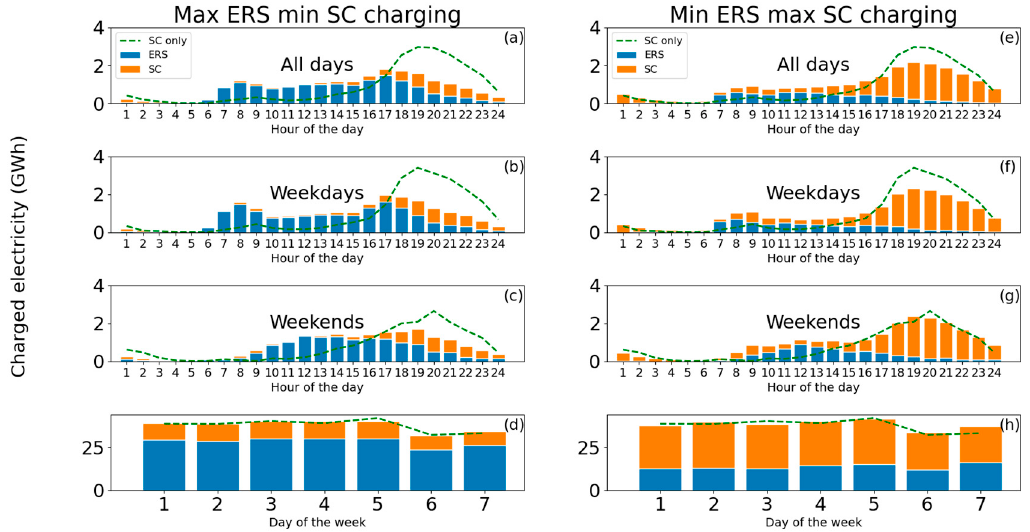
Figure 9. Hourly and daily distribution of EV charging. The dashed line represents the charging with only home stationary charging (SC only). Bars represent charging for E and N25 (2 e ) with the max ERS min SC charging case (left) for ( a ) all days, ( b ) weekdays only, ( c ) weekends only, and ( d ) for each day of the week, where 1 corresponds to Monday and 7 to Sunday. Corresponding results for the min ERS max SC charging case is shown in Figure. ( e – h ) (right). Note that the first three rows have different scales for y-axis than the last row.